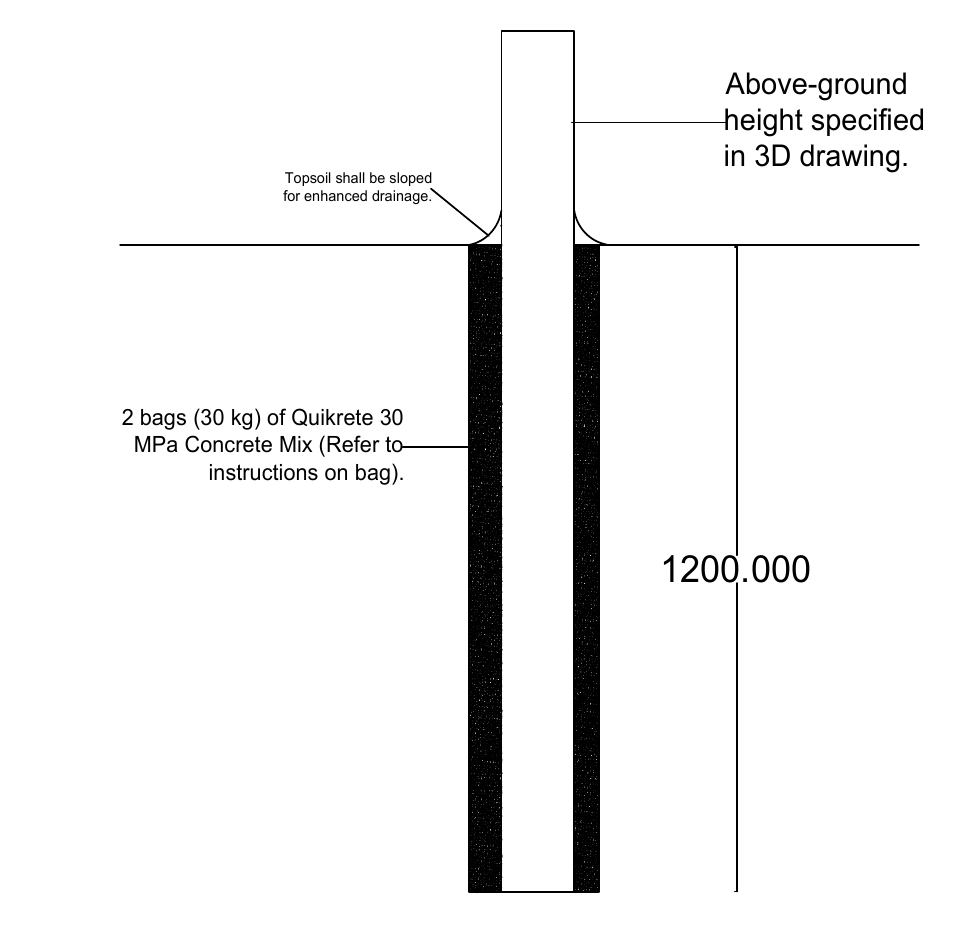
Figure 3. Foundational installment of vertical posts.